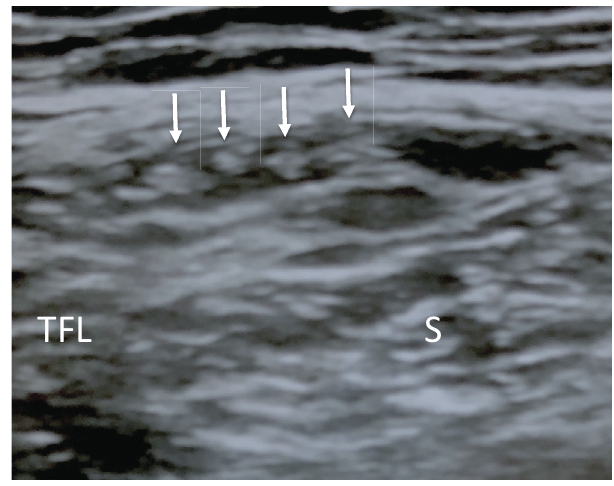
Figure 2. Transverse ultrasound image of the Fan type within the intermuscular space between the sartoirus and the tensor fascia latae. S: Sartorius, TFL: tensor fascia latae muscle, Arrows: several nerve branches.